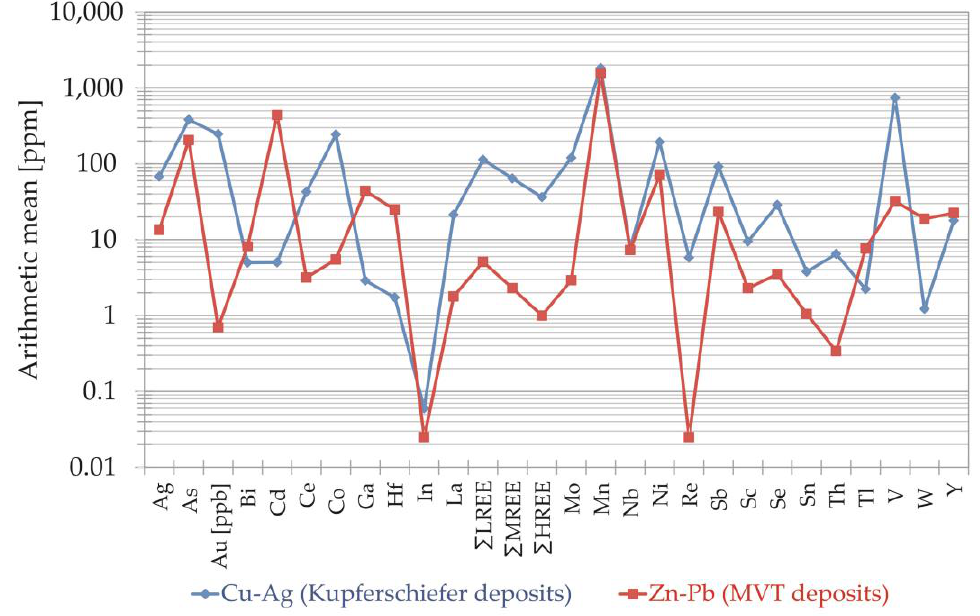
Figure 21. Comparison of arithmetic mean values of selected trace elements in the bulk-rock analyses of Zn-Pb (MVT) and Cu-Ag (Kupferschiefer) sediment hosted deposits in Poland.